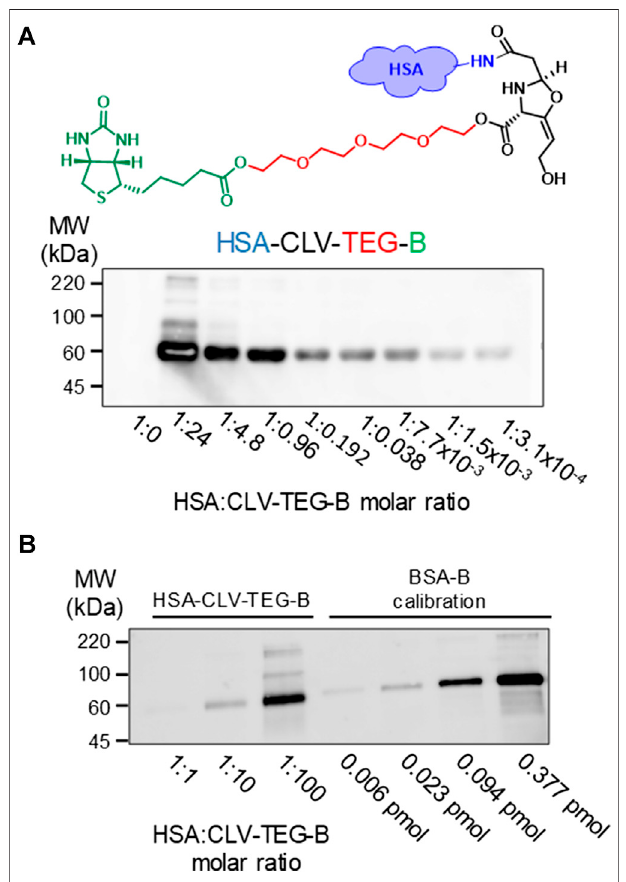
FIGURE3| Detectionofmodi fi cation ofHSA byCLV-tetraethylenglycol- Biotin (CLV-TEG-B). Human serum albumin (HSA) was incubated in the presence of CLV-TEG-B for 16 h at 37 ° C. HSA:CLV-TEG-B molar ratios are shown in fi gure (A) Aliquots of the haptenation reactions containing 2 µg of protein were analyzed by SDS-PAGE and CLV-TEG-B modi fi cation was detected by blot with streptavidin-HRP and ECL detection (B) 0.15 µg aliquots of HSA-CLV-TEG-B (left) and 0.006 – 0.377 pmol aliquots of BSA-B standards (right) were analyzed by SDS-PAGE followed by blot with streptavidin-HRP and ECL